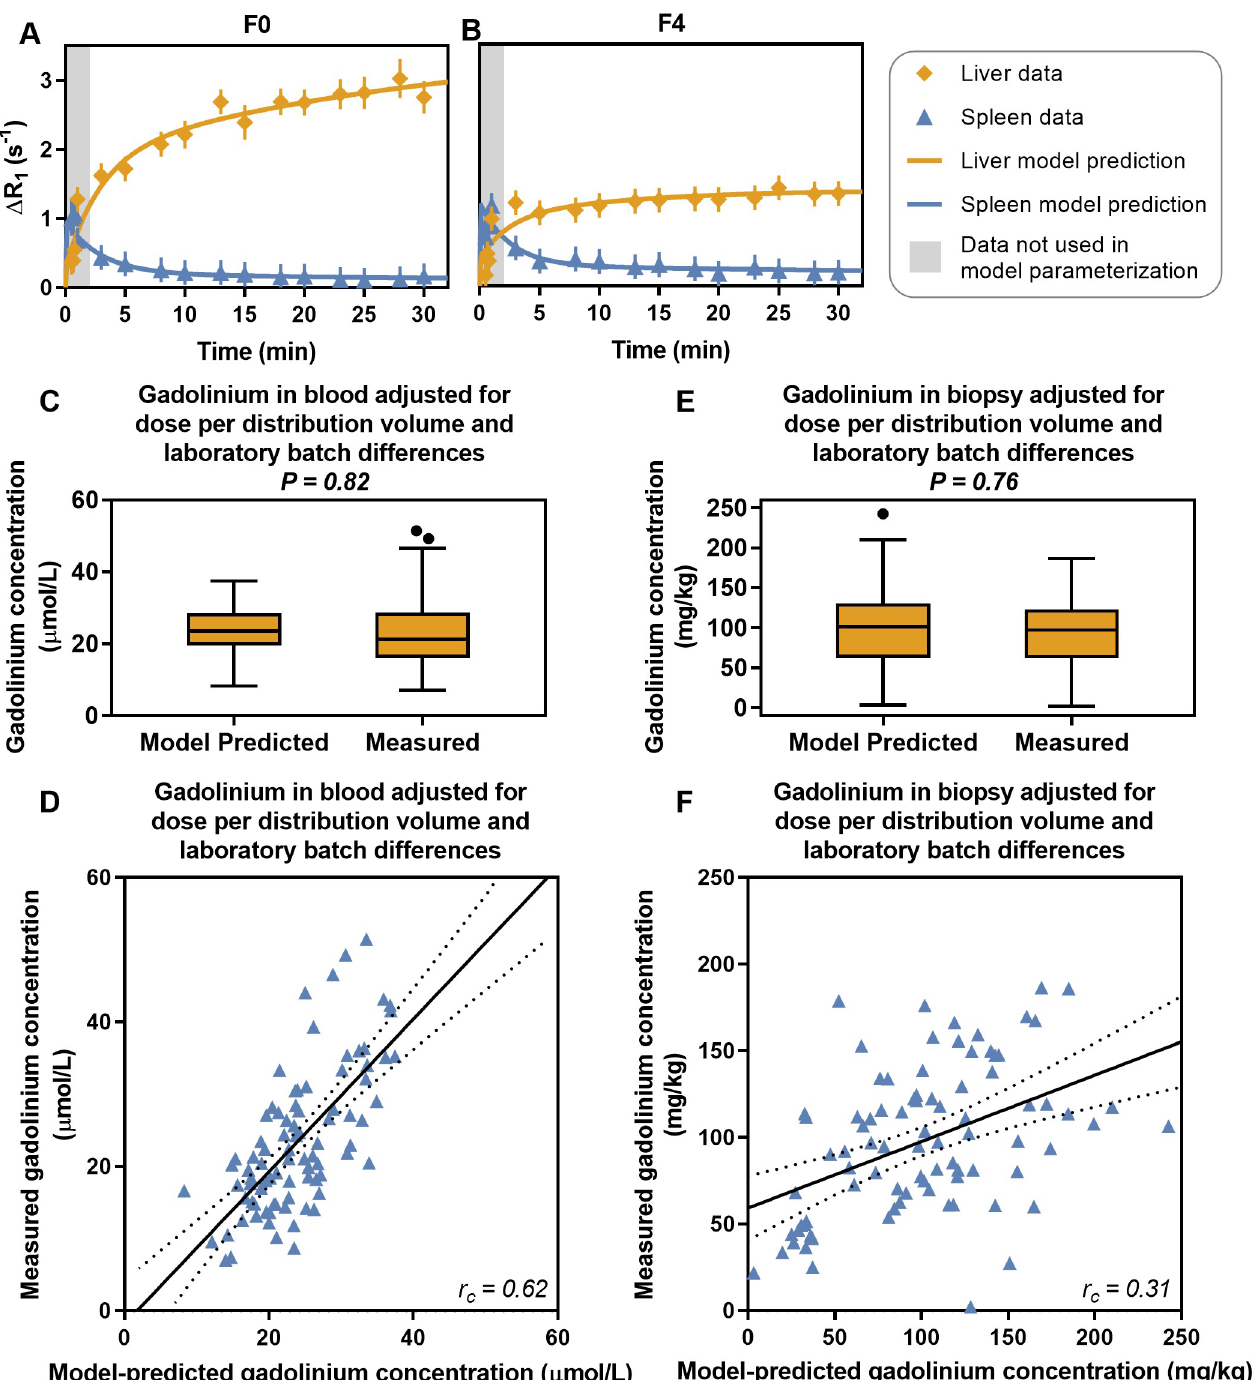
Fig 2. The mechanistic model framework predicts observed gadoxetate levels in chronic liver disease. ( A, B ) Observations and model-based predictions of gadoxetate levels, indicated by the changes in R 1 relaxation rate ( Δ R 1 , which is directly proportional to the gadoxetate concentration) in two patients, one with no fibrosis (F0) and one with histologically proven cirrhosis (F4). ( C, E ) The model is validated by predicting the gadoxetate concentration in blood and biopsy samples, which was acquired after the MRI examination. ( D, F ) Correlation between the measured and model-predicted gadolinium concentrations. The solid line is a linear regression and the dotted lines are 95% confidence intervals.